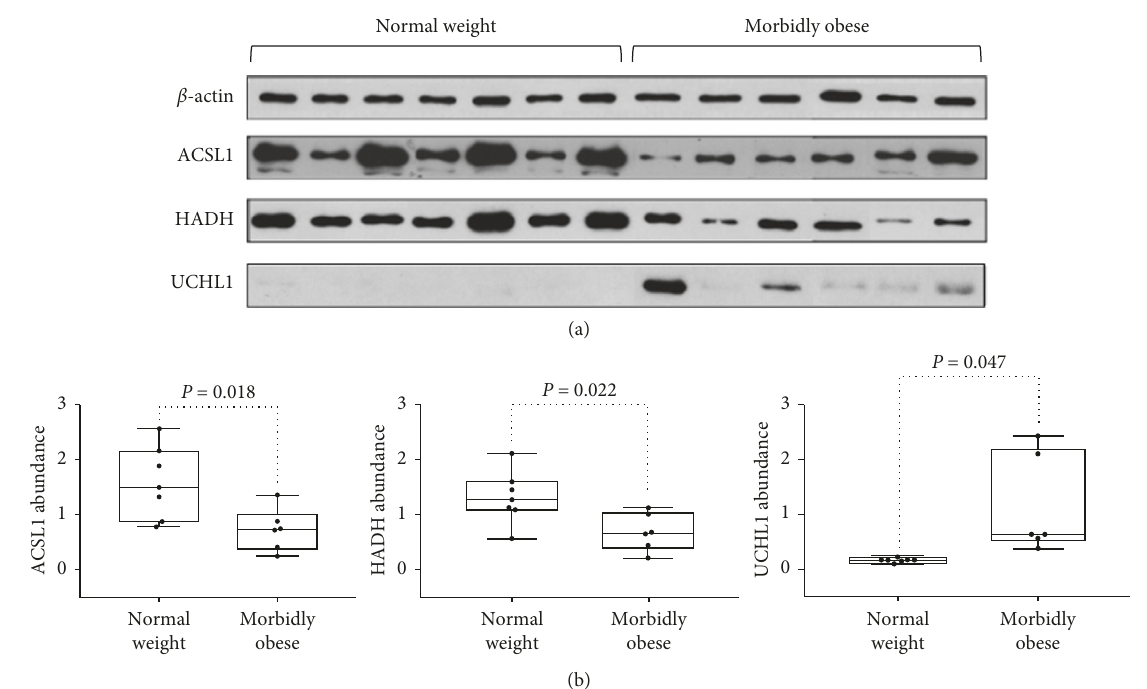
Figure 5: Western blot analysis of ACSL1, HADH, and UCHL1. (a) Three differential VAT proteins (HADH, ACSL1, and UCHL1) were validated by western blotting using the same set of VAT samples from 6 morbidly obese and 7 normal weight patients. (b) The box plots showed the density values from western blotting results between morbidly obese and normal weight